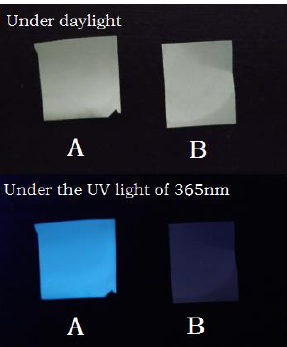
Figure 8. Fluorescent PMMA films prepared by mixing nanogel of P(BPMA- co -ProHEMA)gel- b -PMMA (0.5% weight percent) with PMMA.